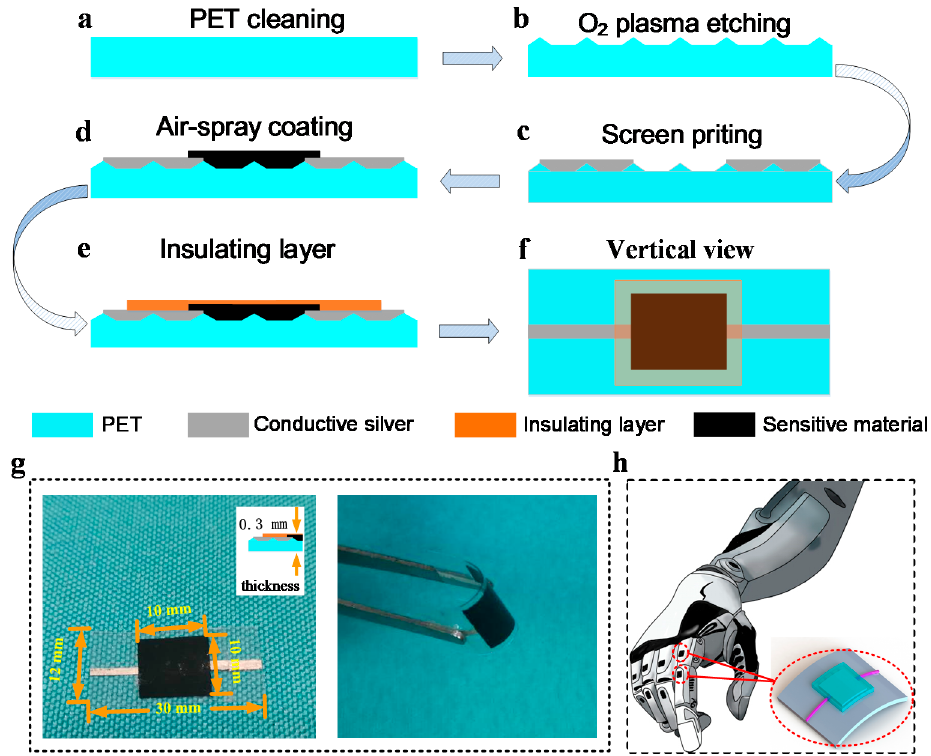
Figure 1. Fabrication process of the temperature sensors: ( a ) polyethylene terephthalate (PET) cleaning with acetone, alcohol and deionized (DI) water; ( b ) O 2 plasma etching; ( c ) printing two conductive thin wires; ( d ) the fabrication of sensitive layer using air-spray coating; ( e ) the fabrication process of insulating layer; ( f ) the vertical view of the temperature sensor; ( g ) the diagram on the left is a dimensional view of the sensor, including the size of the sensitive area, the overall size and the thickness. The diagram on the left shows the good flexibility of the sensor; ( h ) One of the possible applications of the temperature sensor.